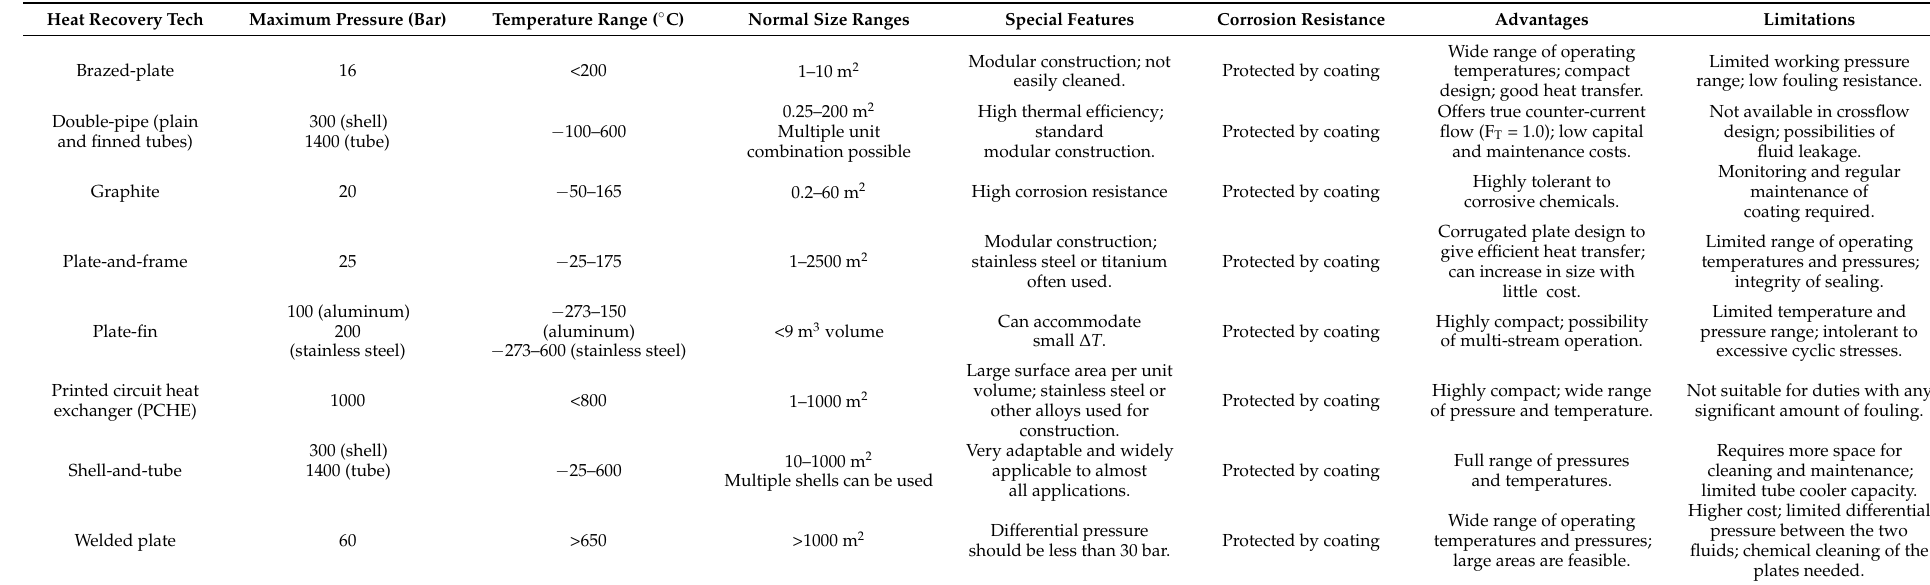
Table 3. Summary of heat recovery technology and technical specification, adapted from